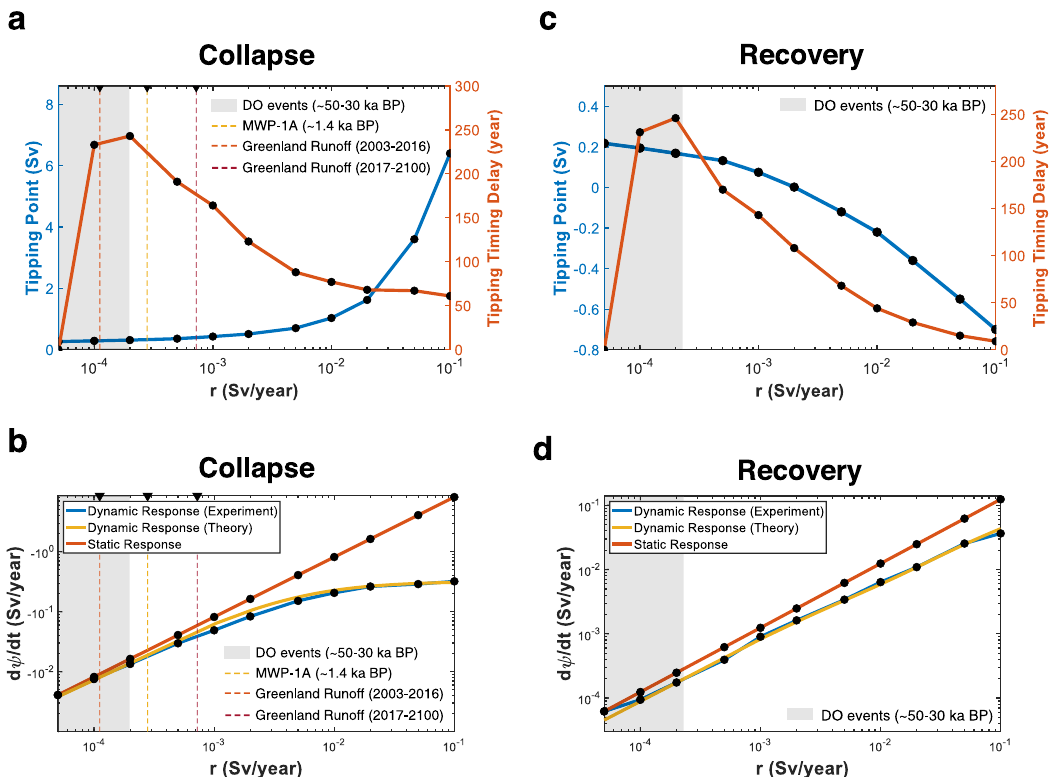
Fig. 4 The tipping modulation experiment with varying freshwater forcing rate using LOVECLIM. a The tipping point (left blue side) and the delayed tipping timing (right orange side) compared to the static tipping point along r for collapse. b The average change rate of AMOC intensity during the collapse. The LOVECLIM experiment result (thick blue line), estimated stationary response (thick orange line), and reproduced changing rate based on the analytical formulation using Eq. (13) (thick yellow line). c and d are the same as a and b , respectively, but for the recovery. For d , the analytical formulation for recovery (Eq. (14)) was adopted instead of collapse (Eq. (13)). For all subpanels, examples of estimated freshwater fl ux forcing (FWF) rates are marked (Table 1). Four examples, DO events (gray shading), MWP-1A (dashed yellow line), Greenland ice sheet runoff for 2003 – 2016 from the GRACE dataset (dashed orange line), and 2017 – 2100 from the CMIP6 SSP5- 8.5 scenario output (dashed red line) are